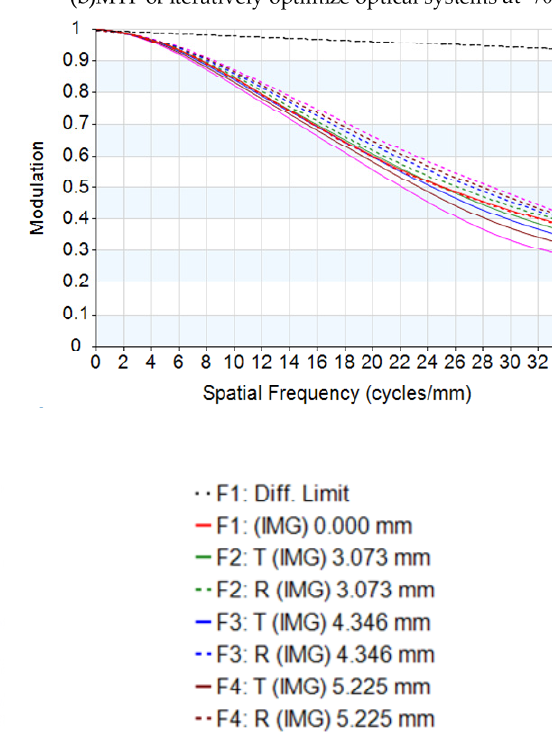
Figure 13. MTF graphs of the lens after iteration optimization with temperatures: ( a ) 20 °C, ( b ) − 70 °C, and ( c ) 100 °C.